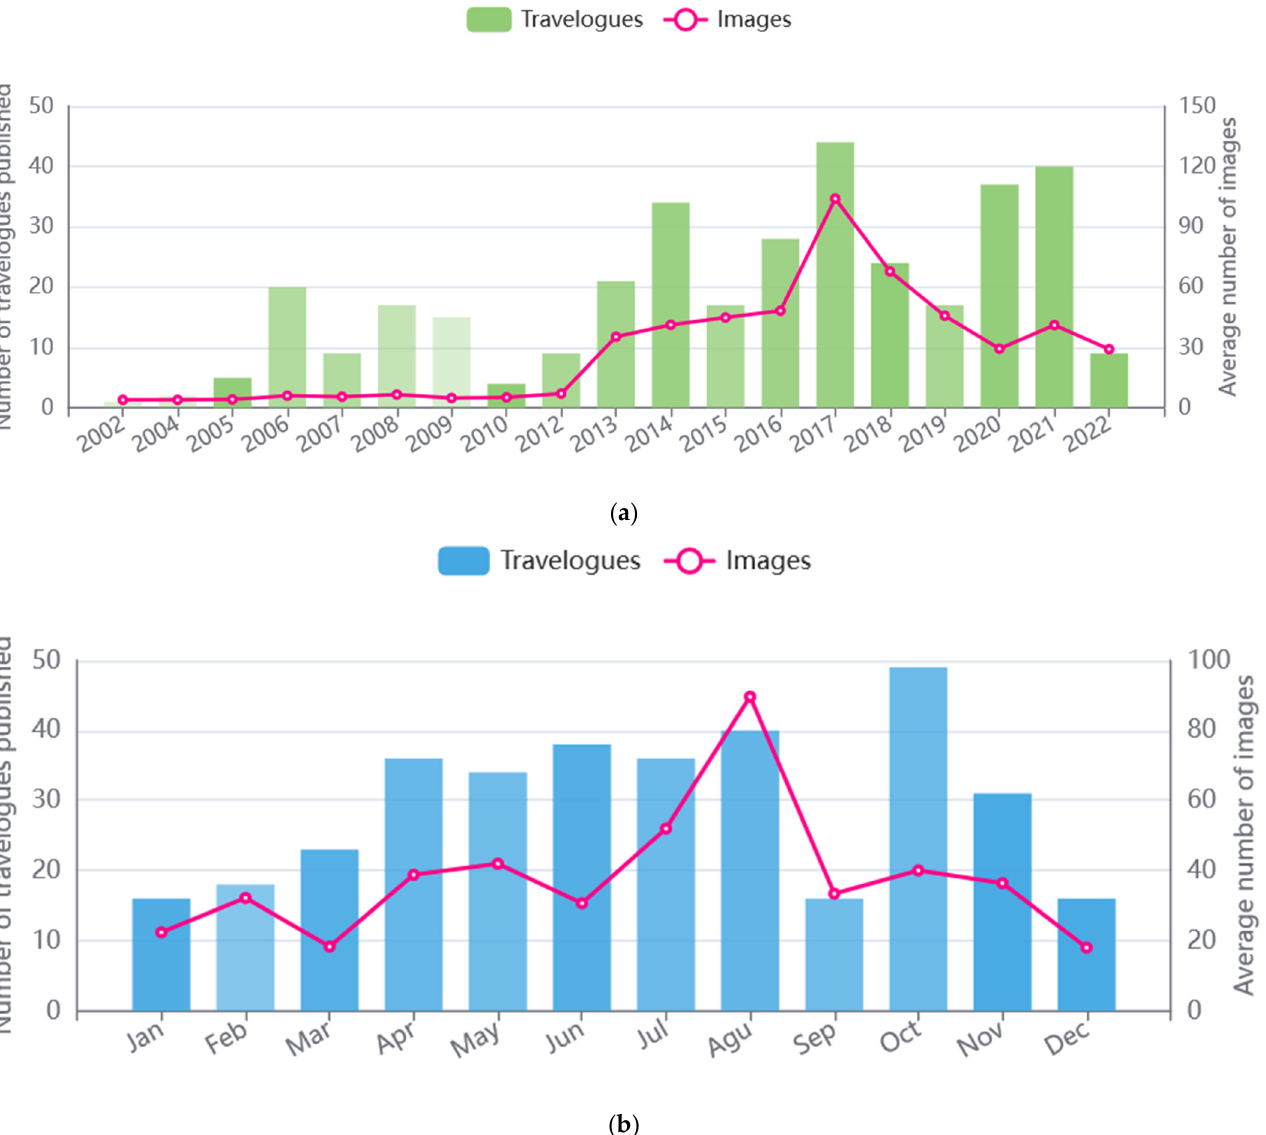
Figure 4. Publication time of travelogues and the average number of photographs per travelogue in Tiantai. The shade of the bar graph color represents the emotion analysis of the travelogue text by the SnowNLP library; the darker the color, the more positive: ( a ) yearly statistics; ( b ) monthly